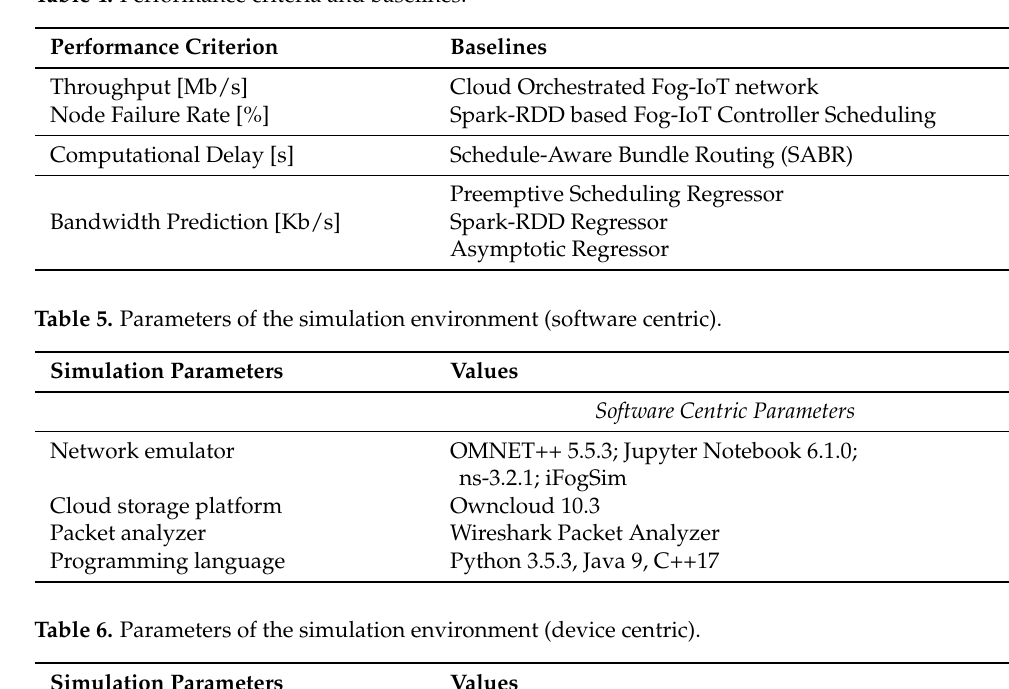
Table 4. Performance criteria and baselines.